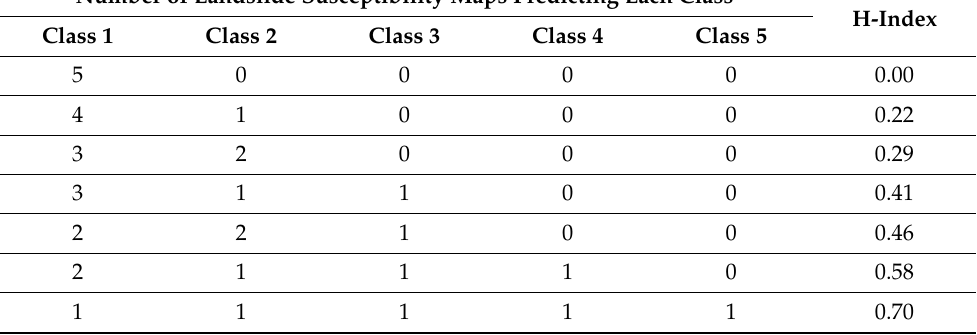
Table 1. Possible H index values while comparing the landslide susceptibility maps produced using five